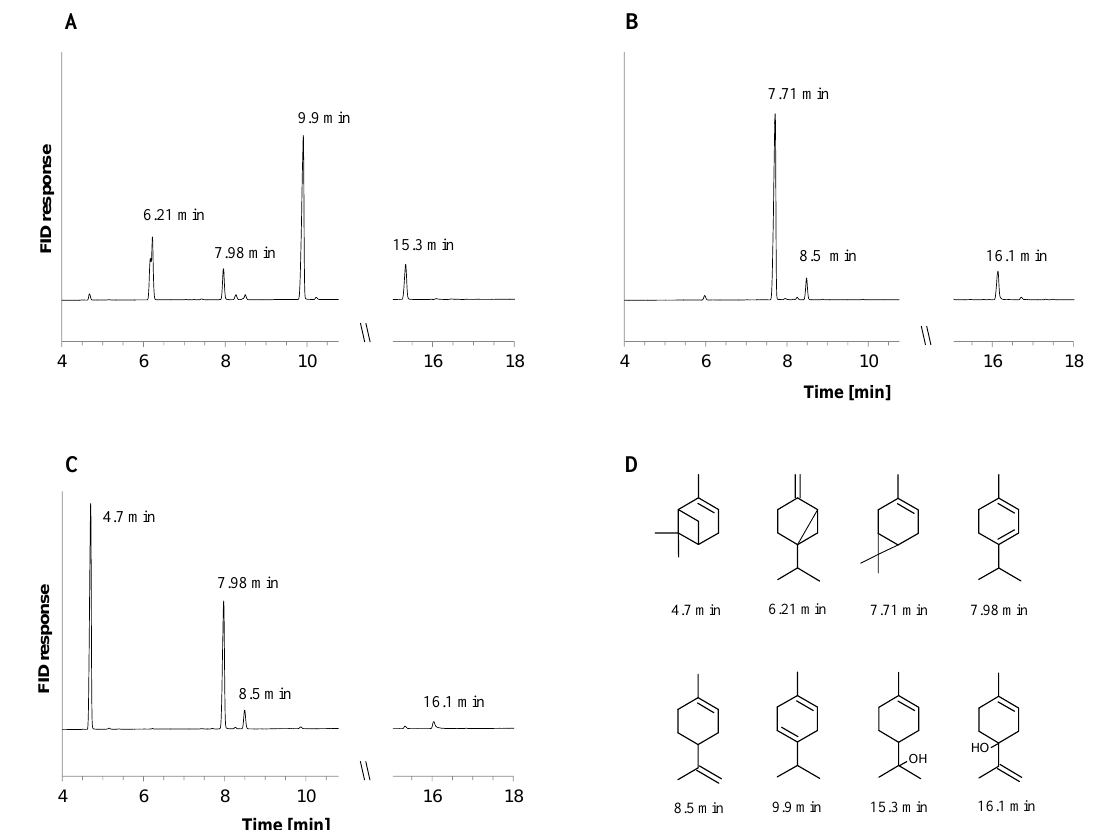
Figure 1. Metabolites formed in cultures of C. defragrans 65Phen Δ ctmAB grown on acetate in co-metabolism with sabinene ( A ), 3-carene ( B ) and α-pinene ( C ). Monoterpenes were identified by retention time and mass spectrum. The retention times of monoterpenes ( D ) are: α-pinene (4.7 min), sabinene (6.21 min), 3-carene (7.71 min), α-terpinene (7.98 min), limonene (8.5 min), γ-terpinene (9.9 min), terpinen-4-ol (15.3 min) and α-terpineol (16.1 min).